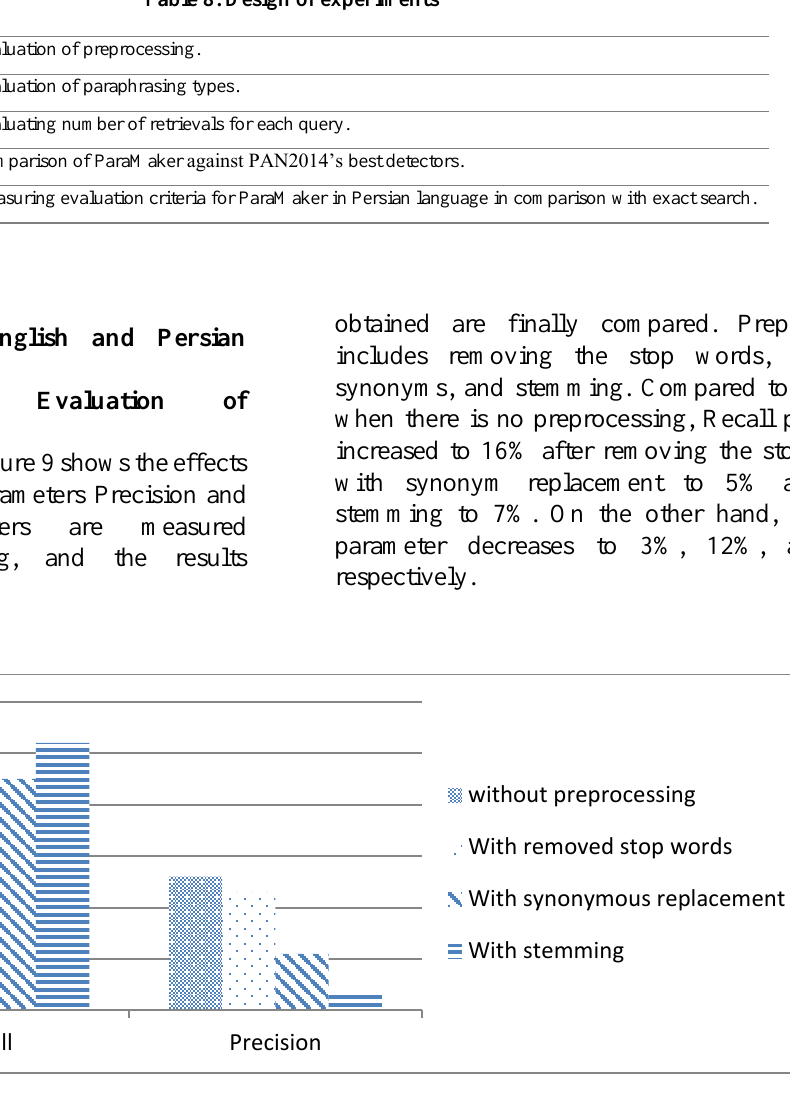
Table 8. Design of experiments